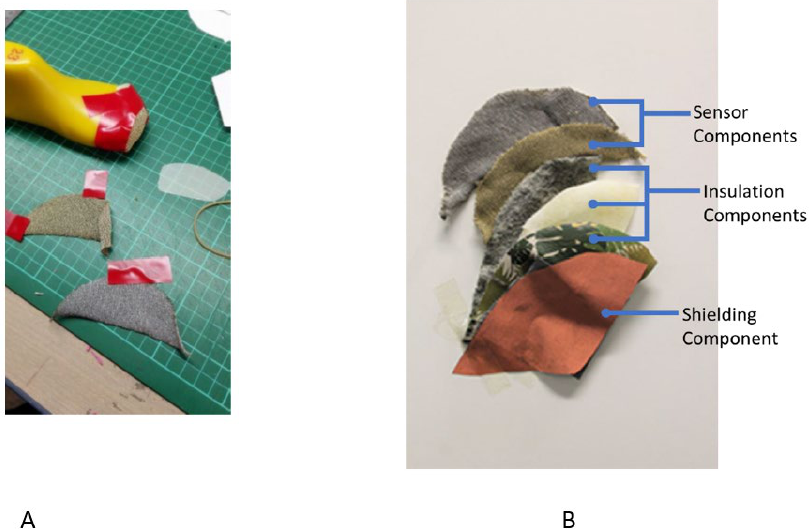
Figure 5. ( A ): Samples cut to shape using toe-cap template with (i) 99% silver thread sample, (ii)